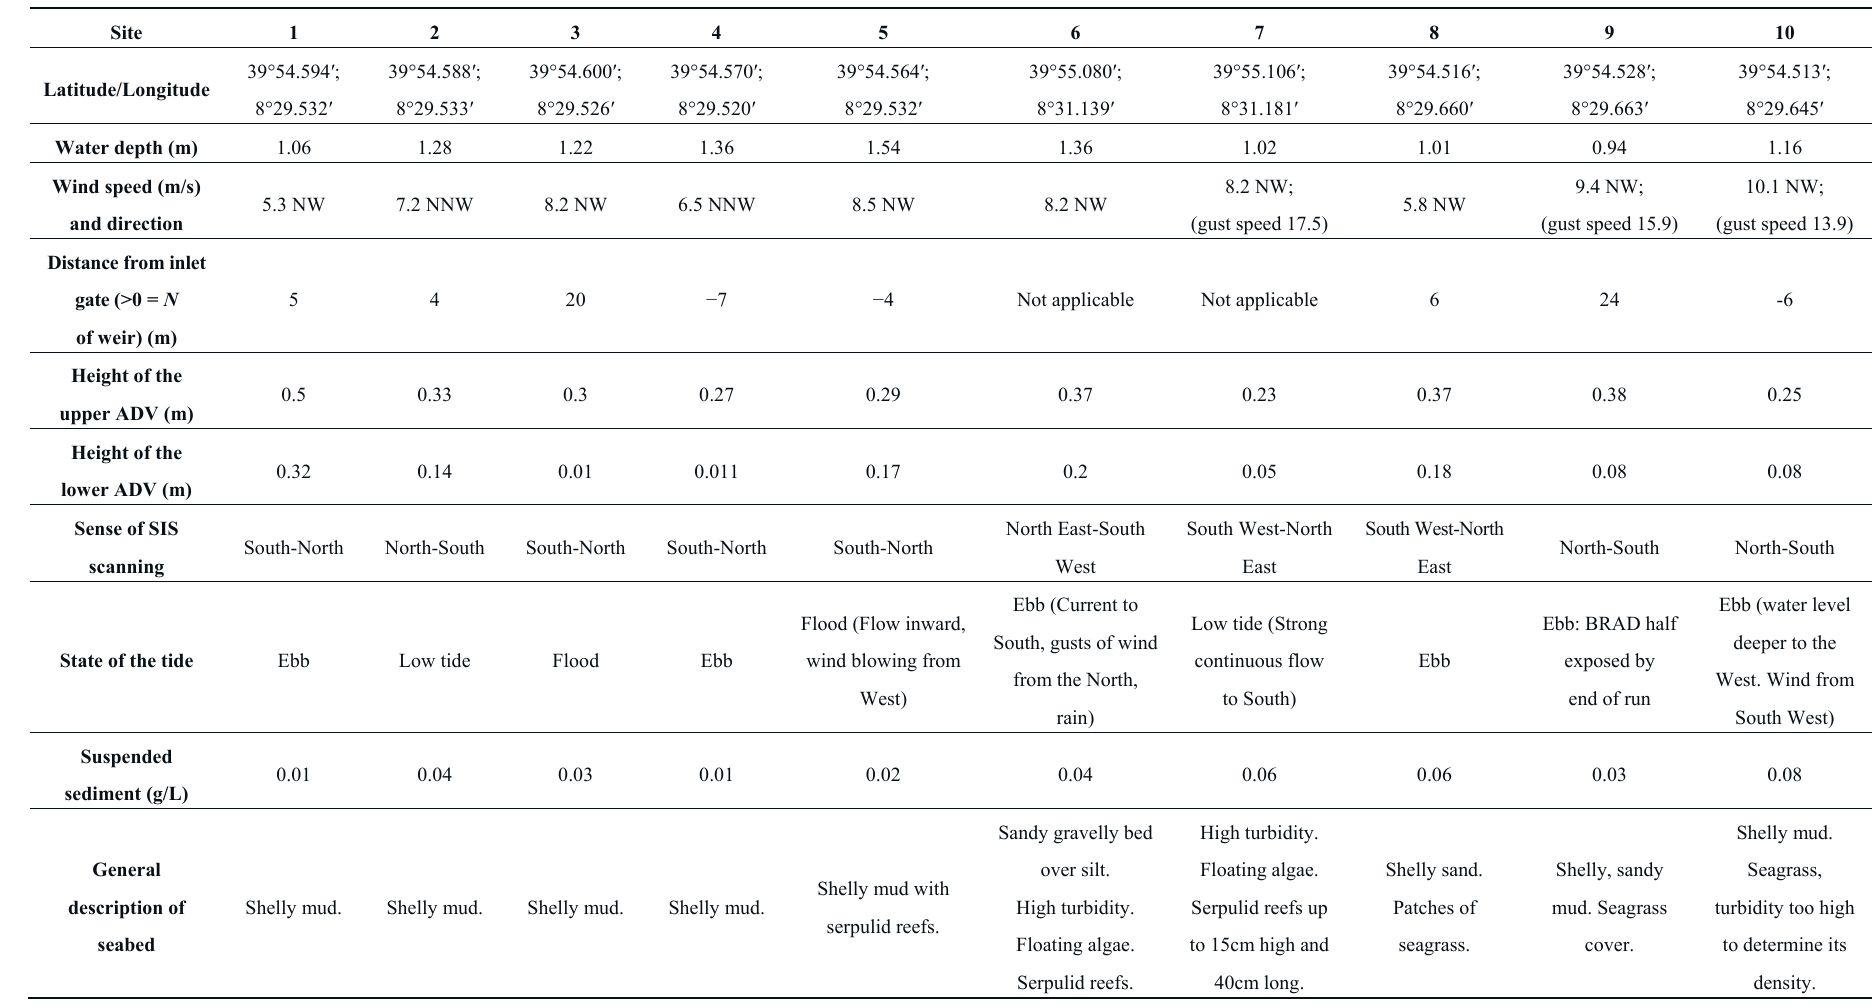
Table 1. A summary of the locations of BRAD sites and characteristics of the seabed. Also given are the heights of the two ADV sensors, the mean water depth, and the direction of travel of the SIS sensor head (Note this was considered important in the registration of the acoustical image to the frame of reference of the two